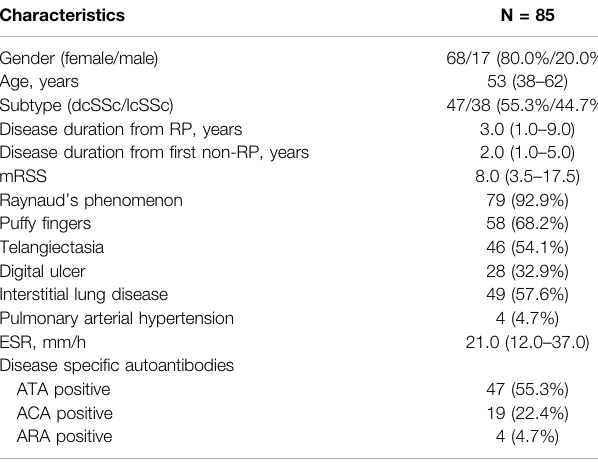
TABLE 1 | Demographic and clinical characteristics of 85 SSc patients.